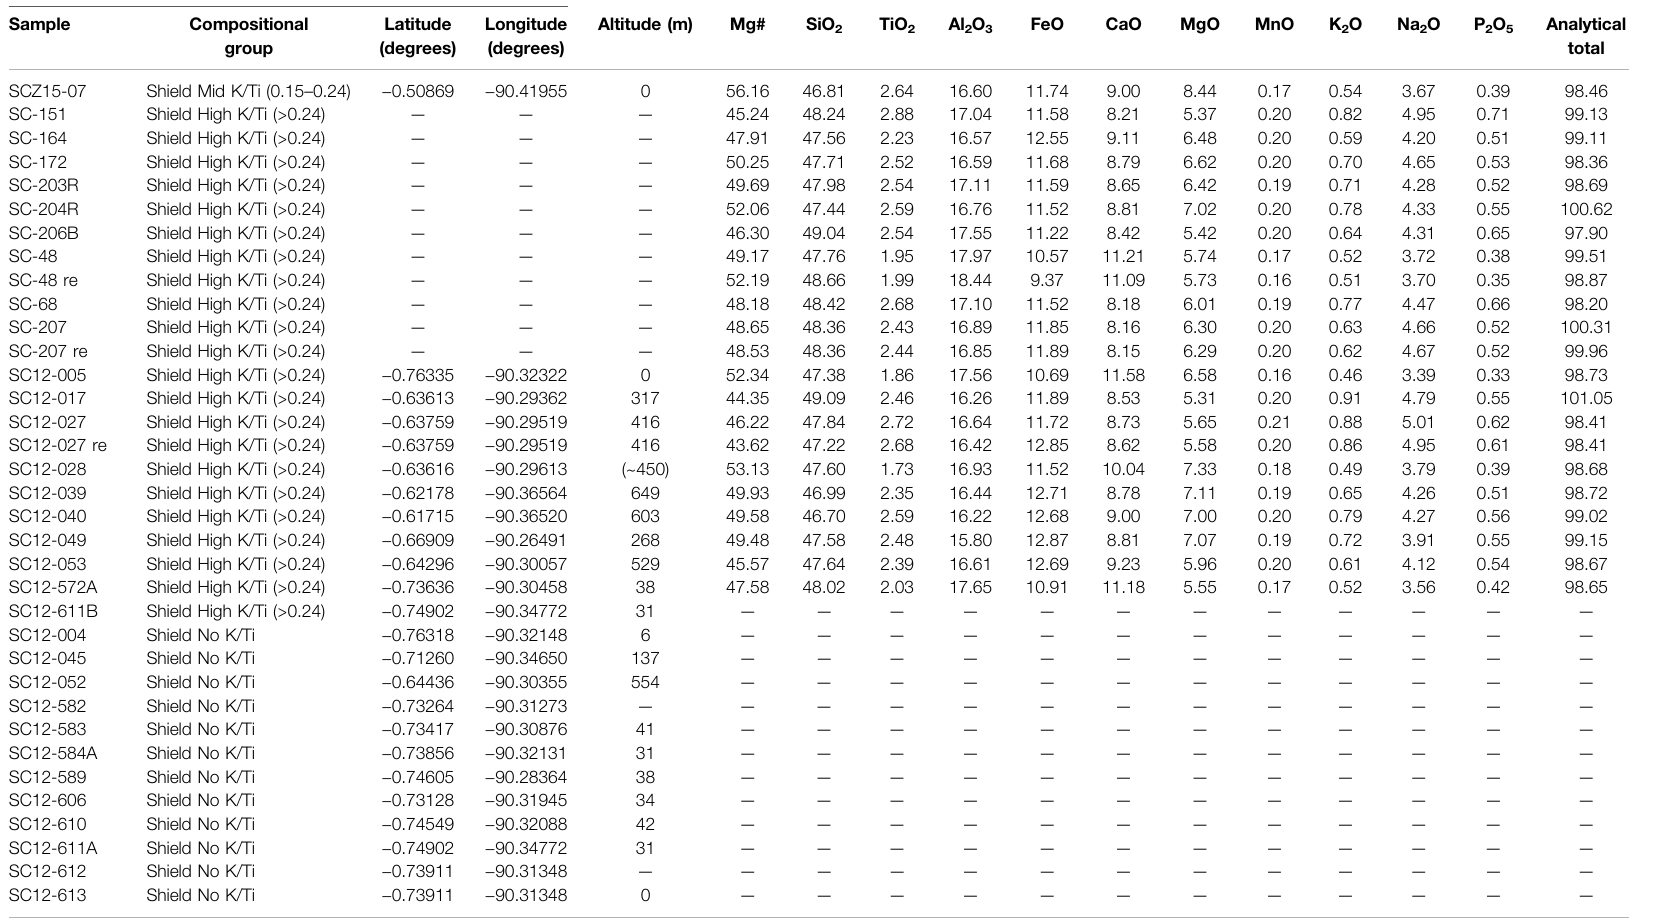
TABLE 1: Sample location and major element abundances (wt.%) Sample Compositional Latitude Longitude Altitude (m) Mg# SiO 2 group (degrees) (degrees) SCZ15-07 Shield Mid K/Ti (0.15 – 0.24) − 0.50869 − 90.41955 Shield High K/Ti ( > 0.24) Shield High K/Ti ( > 0.24) Shield High K/Ti ( > 0.24) Shield High K/Ti ( > 0.24) — Shield High K/Ti ( > 0.24) — Shield High K/Ti ( > 0.24) — Shield High K/Ti ( > 0.24) — — — Shield High K/Ti ( > 0.24) — — Shield High K/Ti ( > 0.24) — Shield High K/Ti ( > 0.24) — Shield High K/Ti ( > 0.24)